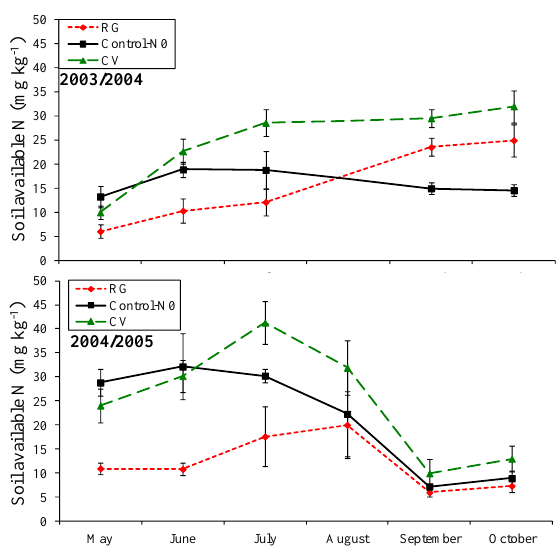
Figure 2. Soil available nitrogen measured during the pepper growing period in 2003/2004 and 2004/2005. Bars are standard errors ( n = 3). RG = Ryegrass.CV = Common Vetch.